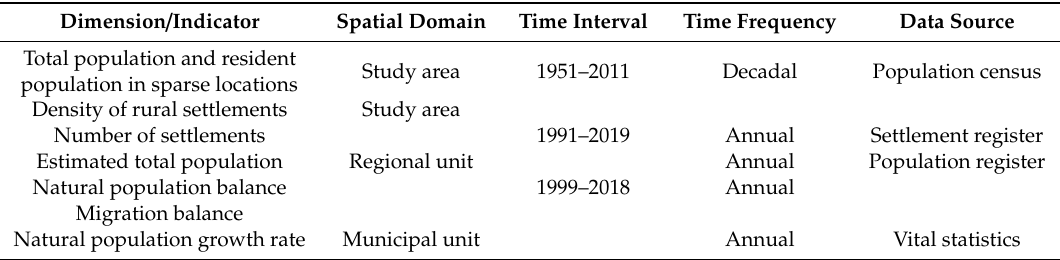
Table 1. A summary of analysis dimensions, data sources and technical details (spatial domain indicates the elementary analysis unit, from the regional level (study area) to the local level (municipal